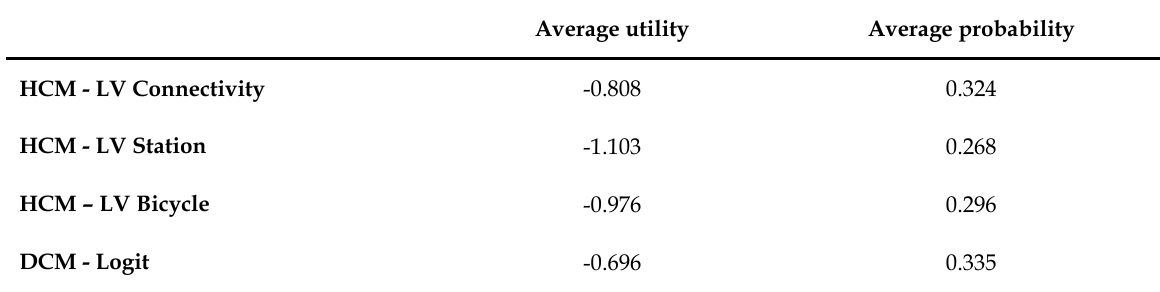
Table 4. Average utility and probabilities